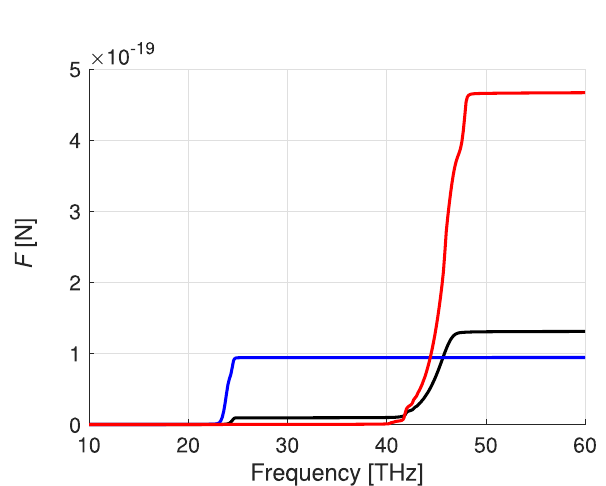
Figure 4. Casimir force per frequency unit versus frequency in the vicinity of the ǫ calculated for the thickness h shows the Casimir force per frequency unit calculated for an isotropic material with permittivity ǫ 100 nm. h =